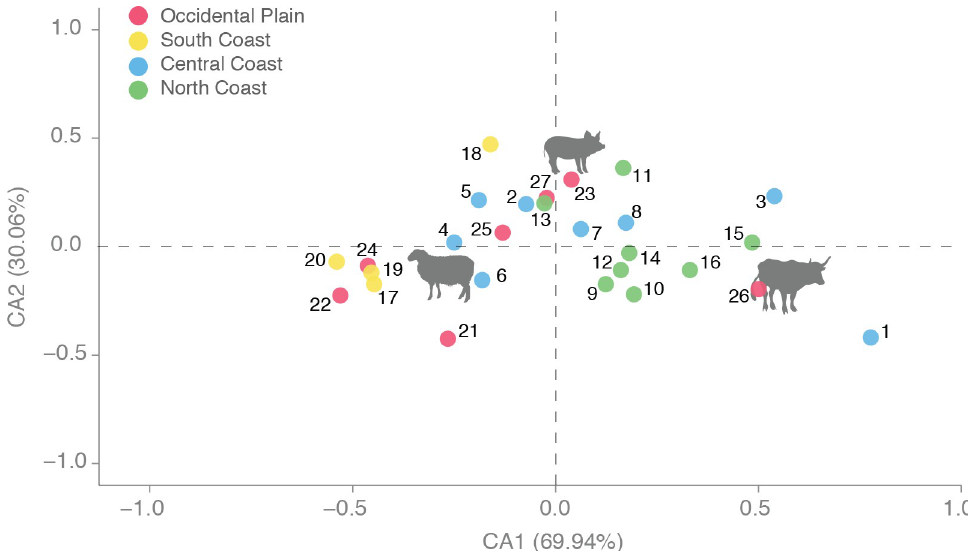
points), South Coast (yellow points), Central Coast (blue points), North Coast (green points). Main domestic species (i.e. statistical variables) are represented by their animal shape. Numbers refer to zones and periods: 1. CC-LBA; 2.CC-EIA; 3. CC-ERE; 4.CC-MIA1; 5.CC-MIA2; 6.CC-LA; 7.CC-ERE; 8.CC-RR; 9.NC-LBA; 10.NC-EIA; 11.NC-ERE; 12.NC-MIA1; 13.NC-MIA2; 14.NC-LA; 15.NC-LRE; 16.NC-RR; 17.SC-EIA; 18.SC-MIA1; 19.SC-MIA2; 20.SC-RR; 21.OP-LBA; 22. OP-EIA; 23.OP-ERE; 24.OP-MIA1; 25.OP-MIA2; 26.OP-LRE; 27.